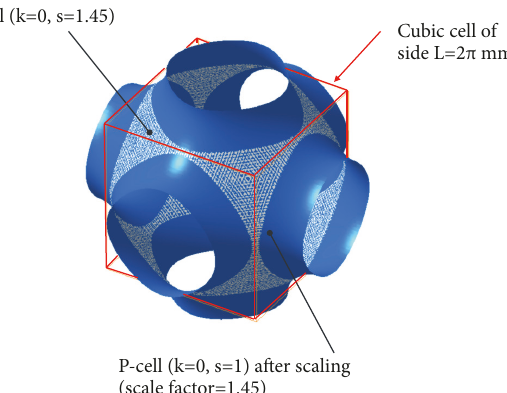
Figure 1: How the modification of the s parameter of the nodal equation (1) affects the P-surface architecture.